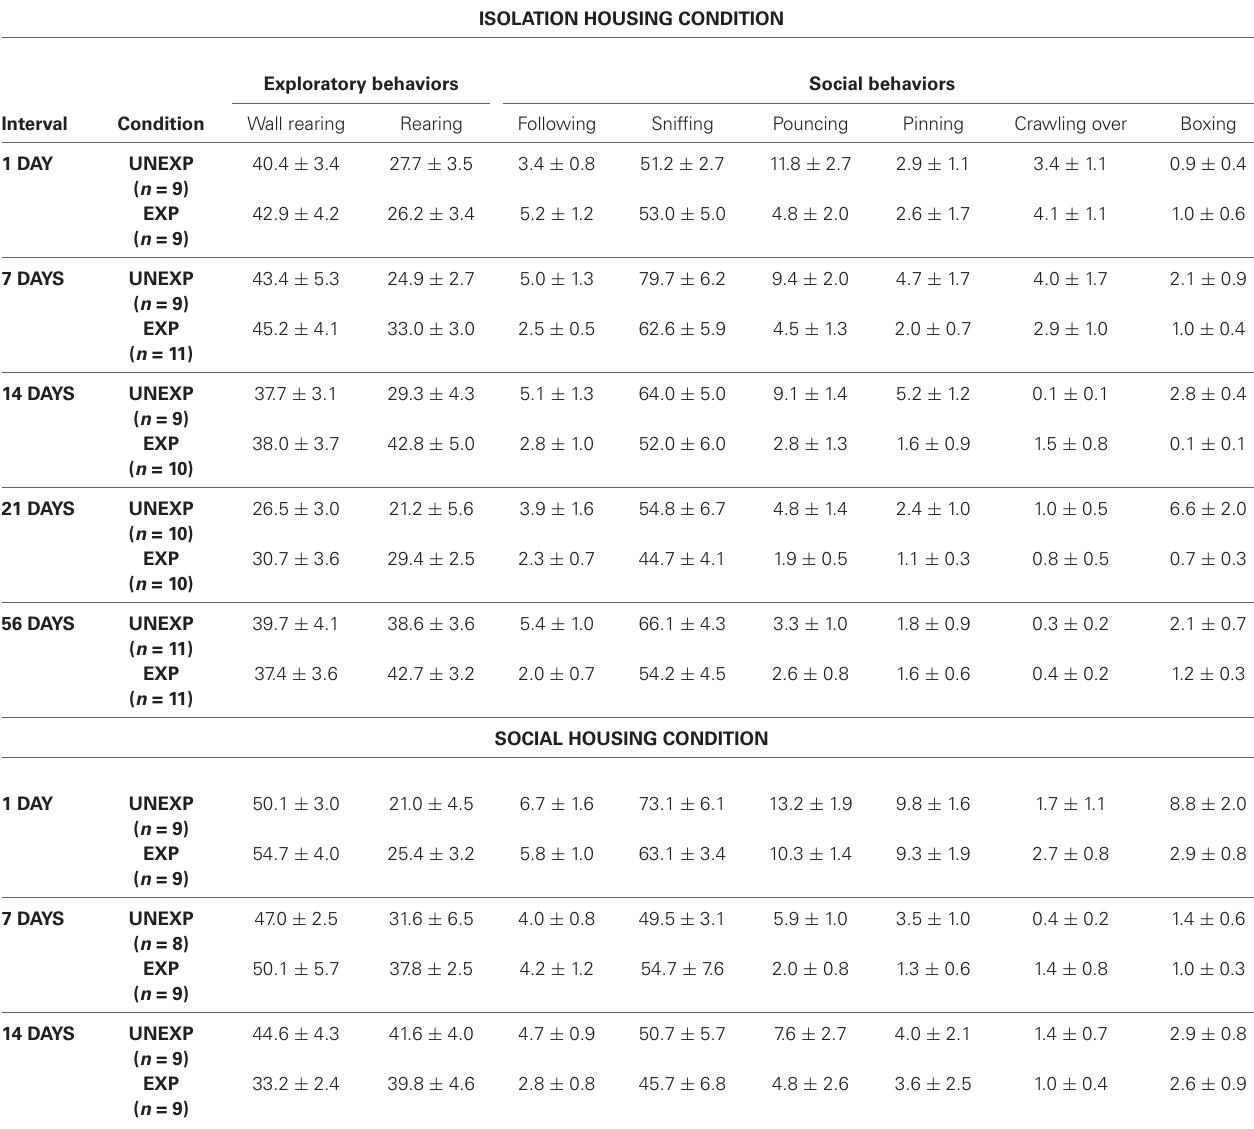
Table 1 | Mean frequencies of behavioral responses of the social interaction test